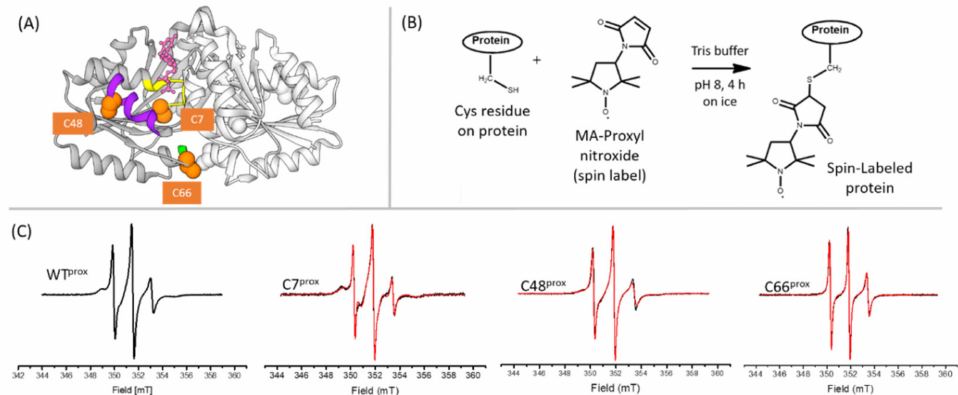
Figure 1. ( A ) Hp UreG structure in the presence of GDP (pink) from the Hp UreG 2 F 2 D 2 crystal (PDB 4HI0). The position of the three natural cysteine residues is highlighted in orange: Cys7 in the P-loop (yellow), Cys48 in the Helix 2 (purple), and Cys66 in the CPH Nickel binding site (green). ( B ) Labeling reaction scheme with MA-PROXYL nitroxide label. ( C ) Room temperature X-band EPR spectra of 50 µ M of wild-type Hp UreG and its variants labeled with MA-PROXYL nitroxide in Tris bu ff er (black trace) and superimposed simulated spectra (red